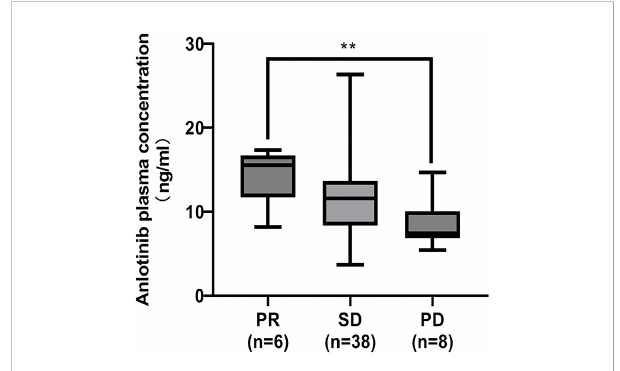
FIGURE 2 Comparison of the median ANL C trough in patients with partial response (PR), stable disease (SD) and progressive disease (PD). The adjusted p values by Bonferroni-corrected test multiplied the p values of each paired comparison group by 3. **represents p<0.01.